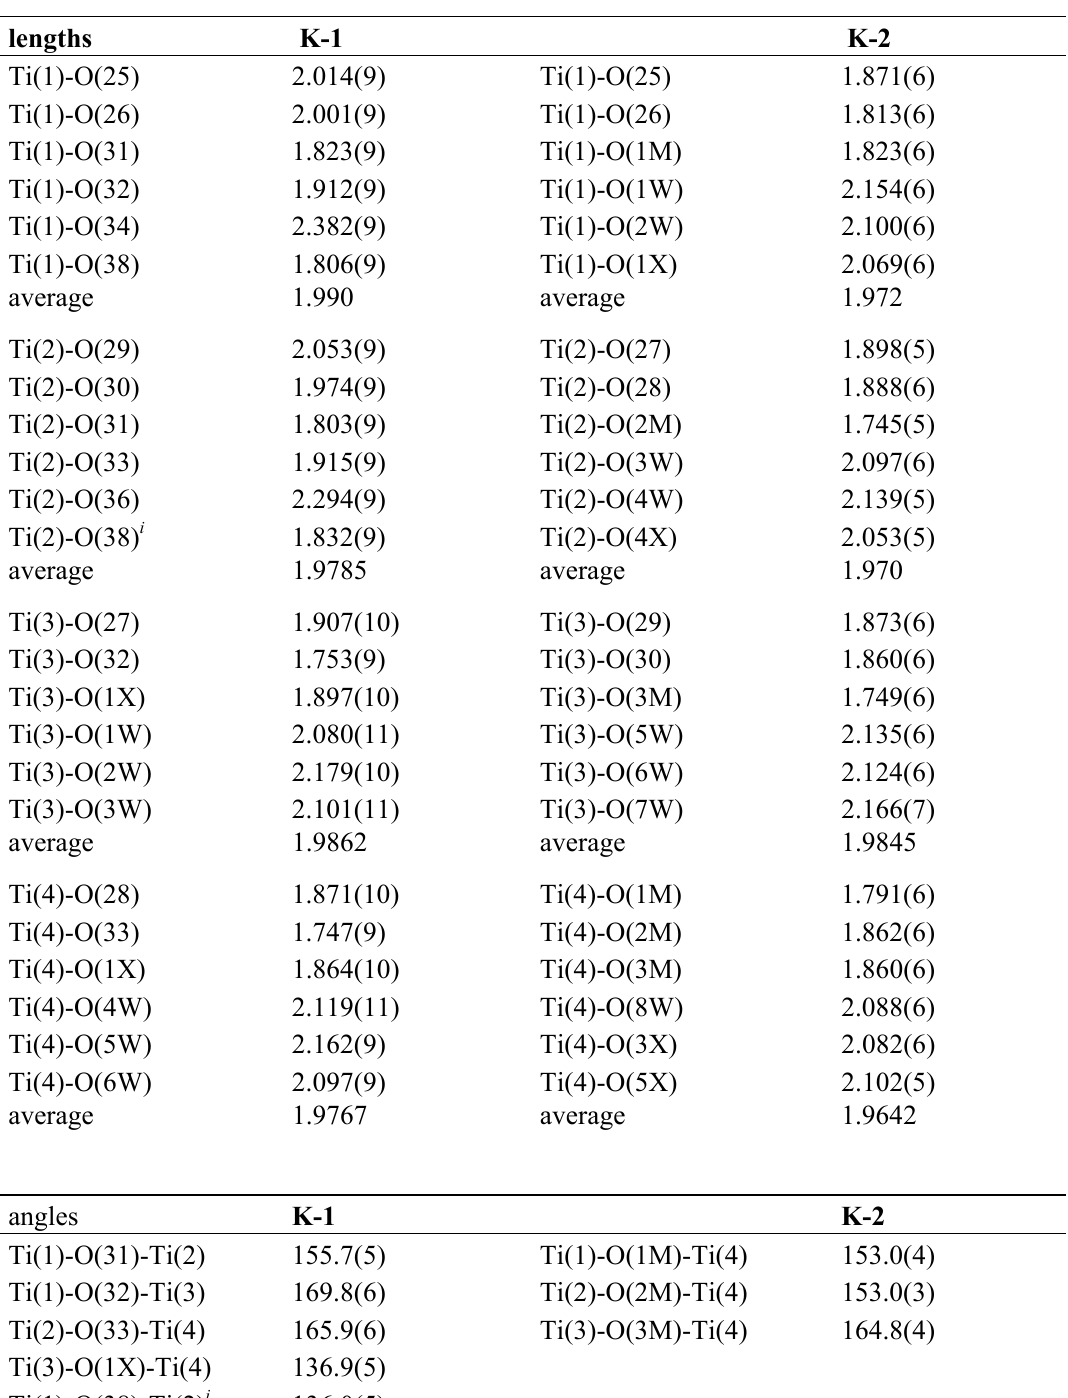
Table 1. Selected bond lengths (Å) and angles ( ° ) around the titanium(IV) centers in K-1 and K-2